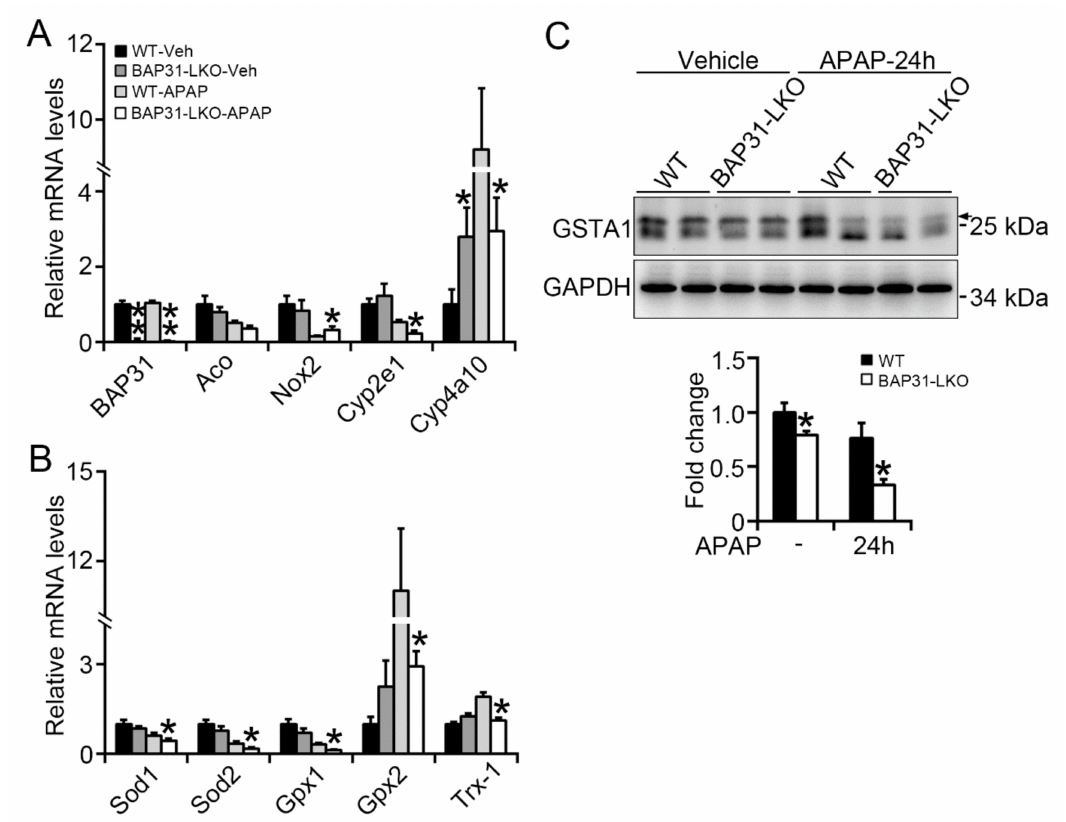
Figure 3. BAP31-deficiency reduced antioxidant and detoxification genes expression. BAP31-LKO mice and the littermates were i.p. injected APAP (300 mg/kg) for 24 h. Liver tissues were harvested, and the total RNA was extracted. The tran- scriptional levels of ( A ) BAP31 , Aco , Nox2 , Cyp2e1 , and Cyp4a10 , ( B ) Sod1 , Sod2 , Gpx1 , Gpx2 , and Trx-1 were determined. The relative mRNA levels were normalized by 18S rRNA levels. n = 5–7 per group. ( C ) The protein levels of GSTA1 were determined using immunoblot analysis in livers from WT and BAP31-LKO mice 24 h post APAP injection. GAPDH was used as the loading control. Data are expressed as mean ± SE. *, p < 0.05, **, p < 0.01, BAP31-LKO compared to WT